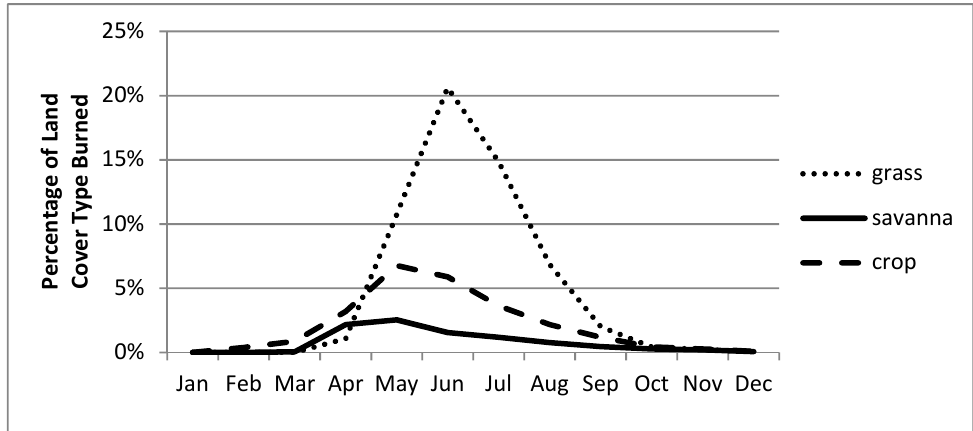
Figure 5. Average percent of monthly burning for major land cover types from 2003 to 2011 taken from MOD14.